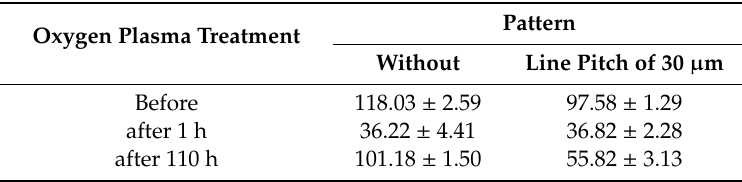
Table 5. Comparison of contact angle of the droplet on the XO RGP contact lens treated by oxygen plasma (Unit: °).